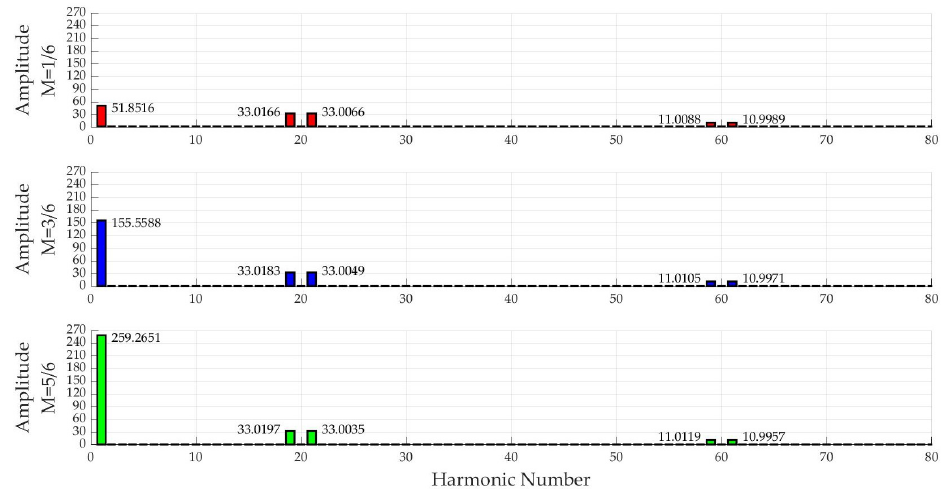
Figure 9. Spectral composition of load voltage at different modulation depths.